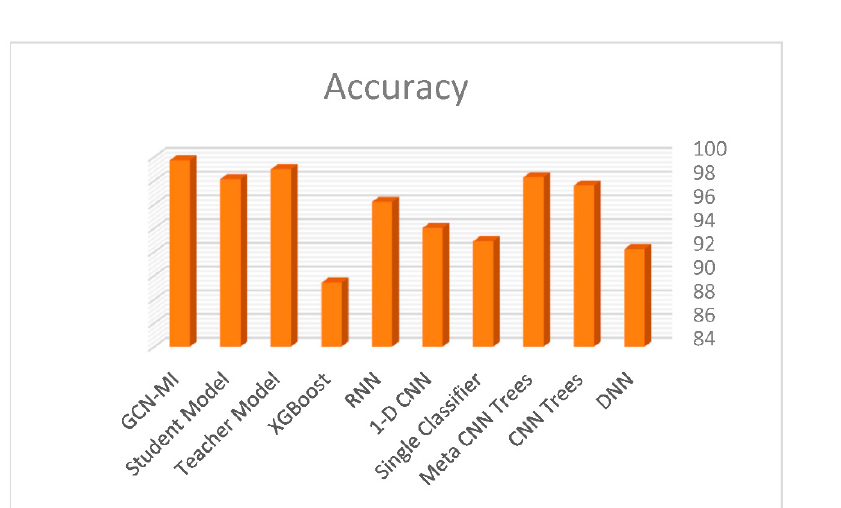
Figure 8. Comparison of deep learning models for arrhythmic diagnosis using the Chapman dataset.